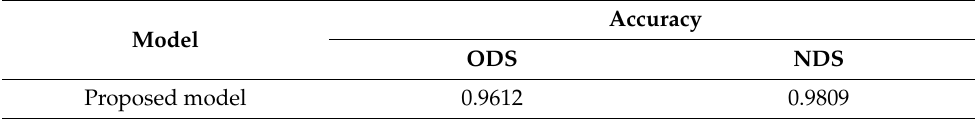
Table 7. Soft voting results for different datasets.